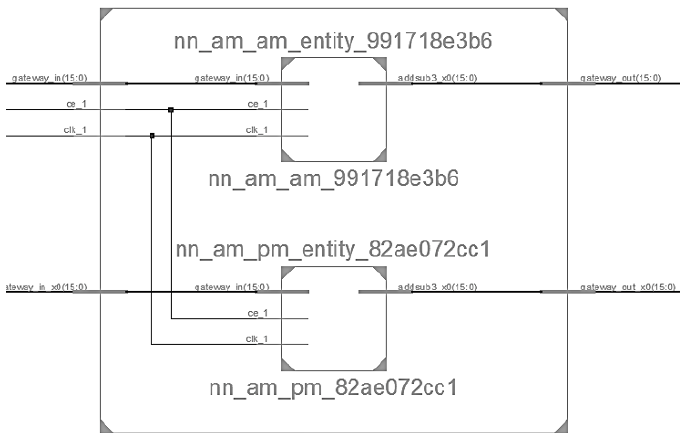
Figure 8. RTL Schematic for NN TWTA and SSPA pre-distorters.